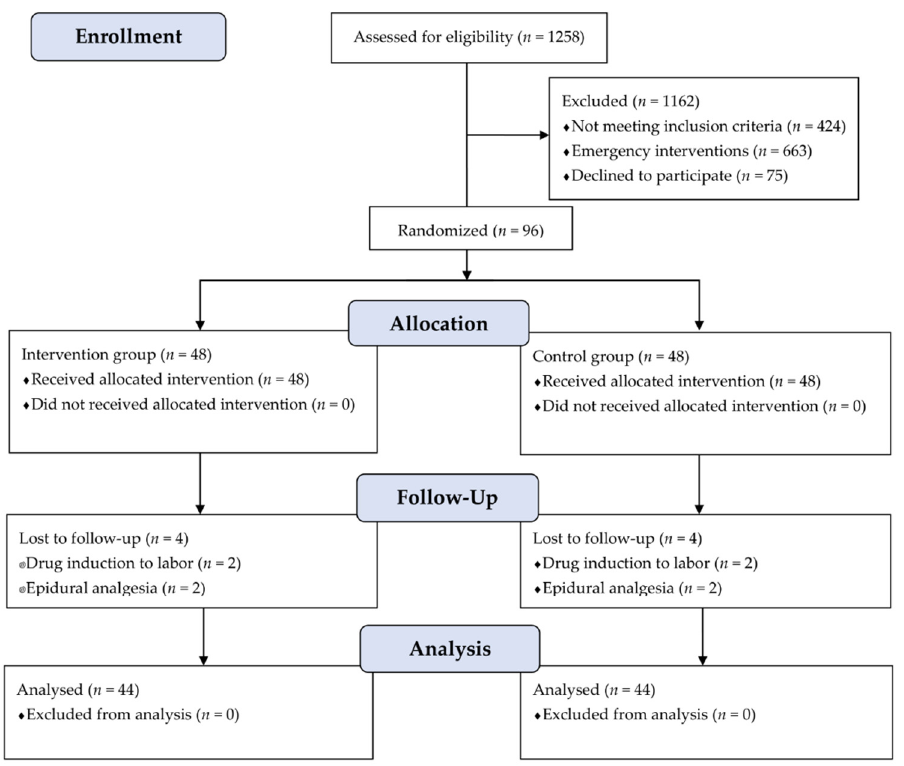
Figure 1. CONSORT diagram of study participants in control and intervention groups.